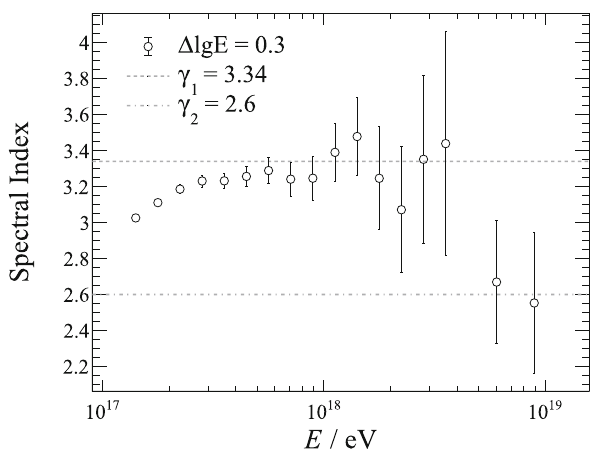
Fig. 14 Evolution of the spectral index with energy. The measured spectral points were fit to power laws within a sliding window of (cid:3) lg E = 0 . 3. The values of γ γ 1 and 2 are represented by the dashed and dash-dotted lines, for reference